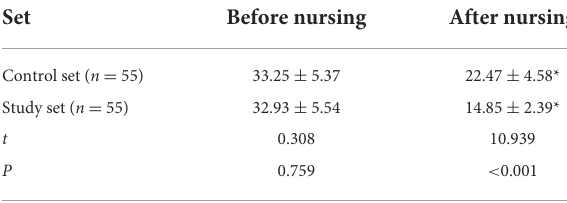
TABLE 5 Contrast of APACHE II scores before and after nursing between the two sets of patients ( ¯ x ± s, points). Set Before nursing